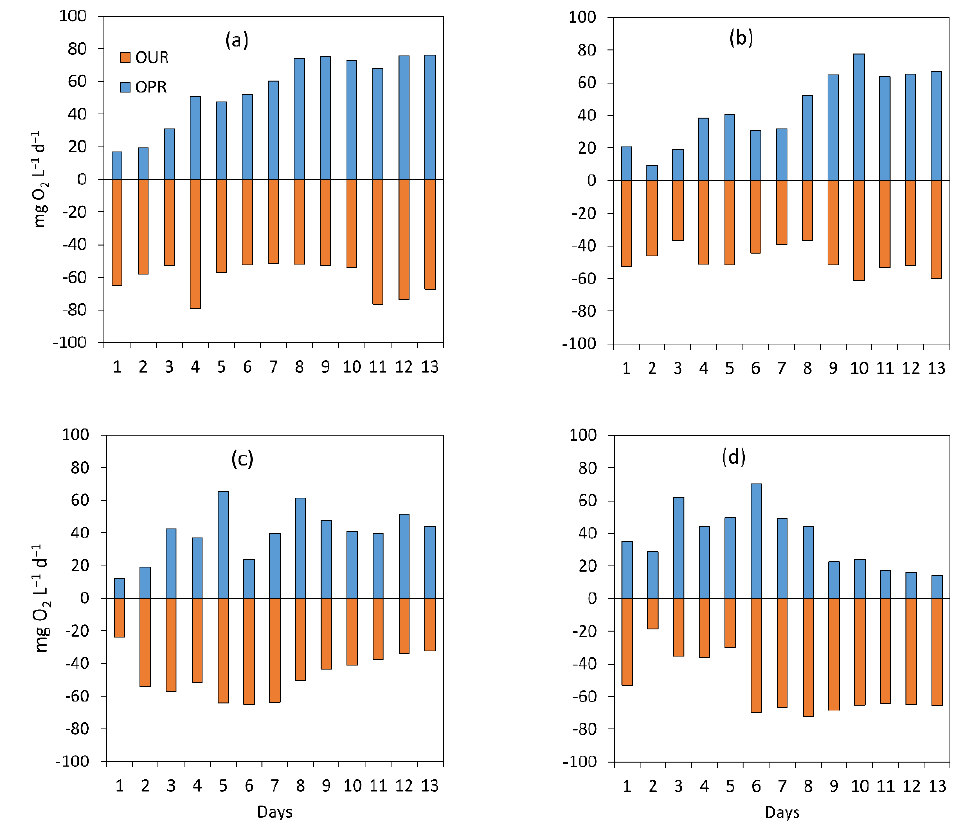
Figure 5. Calculated daily OUR and OPR for different experiments under the impacts of light and nutrient load. ( a ) HL.X5, ( b ) HL.X10, ( c ) LL.X5 and ( d ) nutrient load. ( a ) HL.X5, ( b ) HL.X10, ( c ) LL.X5 and ( d ) LL.X10.